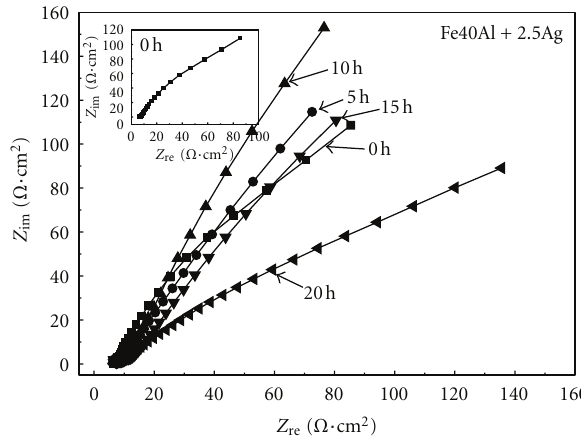
Figure 5: Nyquist diagrams for Fe40Al in the KCl + ZnCl 2 mixture at 670 ◦ C.